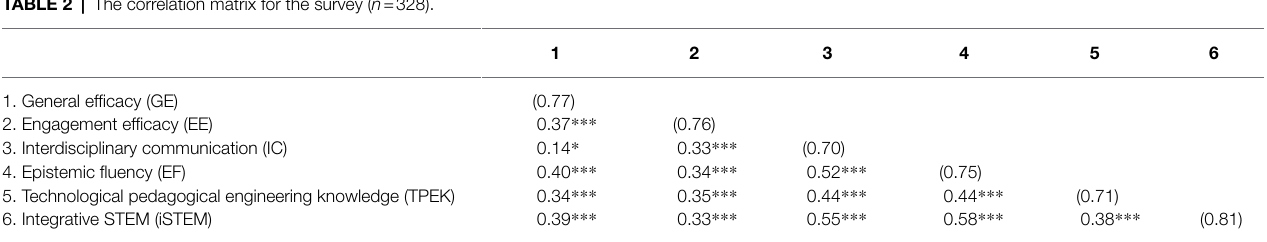
TABLE 2 | The correlation matrix for the survey ( n = 328).